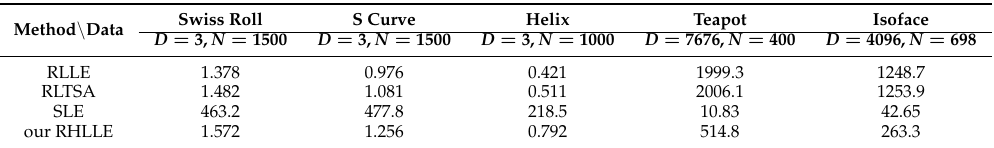
Table 3. The average computation time (in seconds) for different methods on synthetic as well as real-world datasets. D denotes the dimensionality of the ambient space and N denotes the number of the data points in each